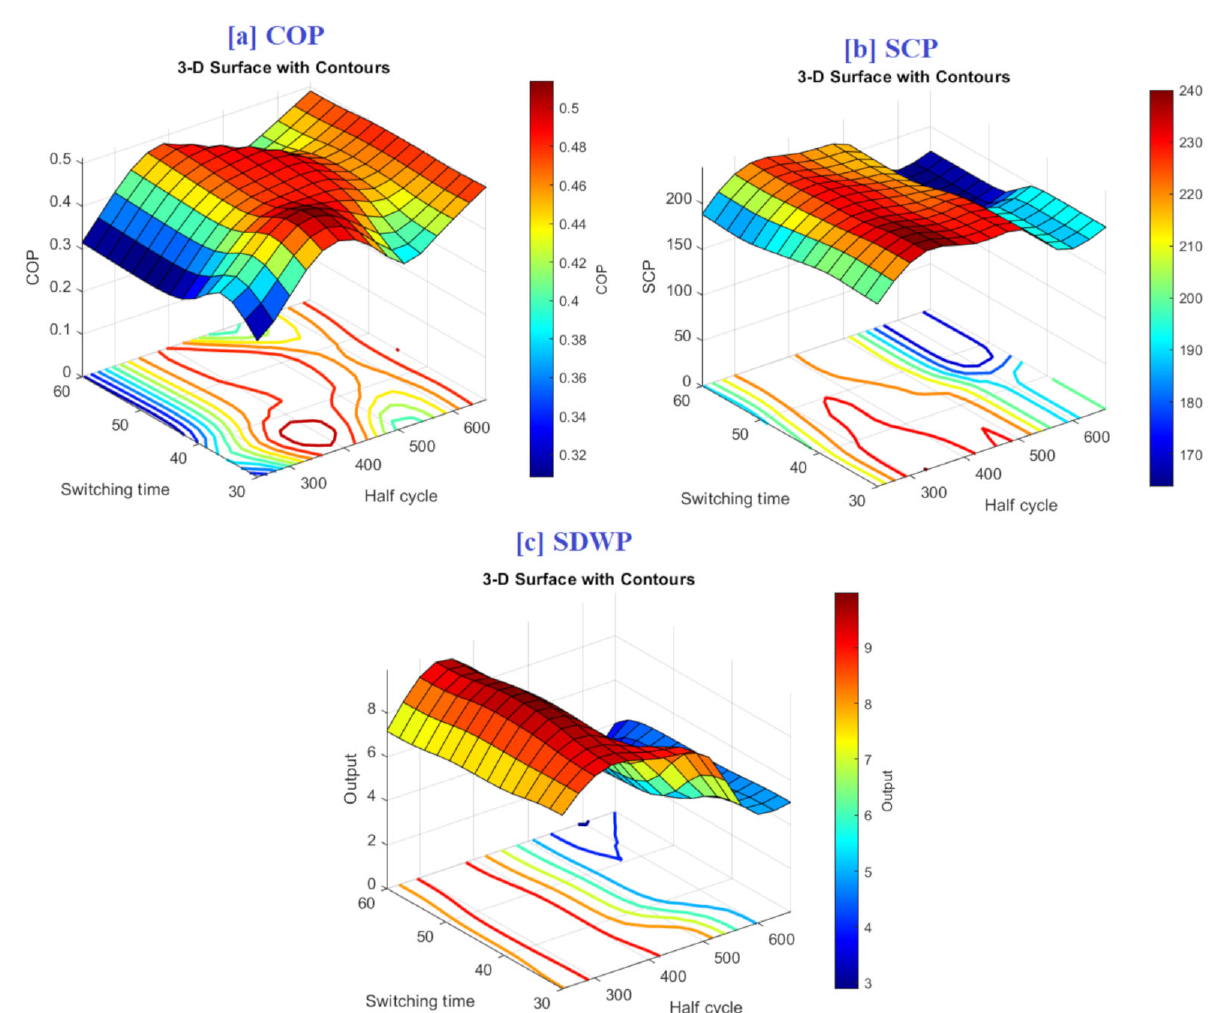
Figure 5. 3-D surface plot of output performance changing values related to input parameters ( a ) COP; ( b ) SCP, and ( c )